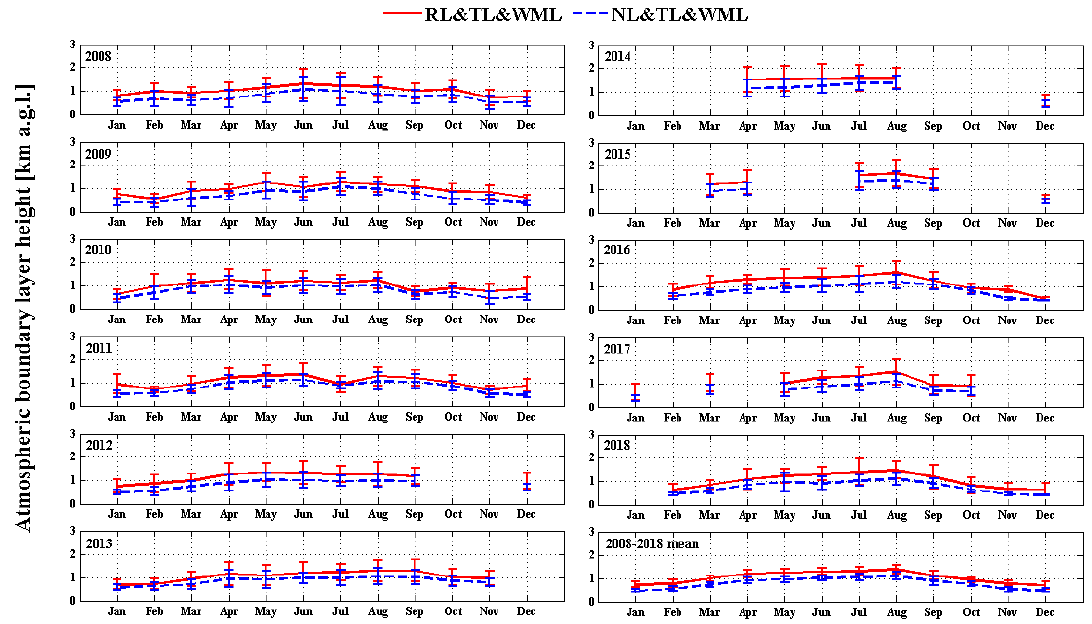
Figure 9. The monthly mean variability of the ABLHs obtained by using the wavelet covariance transform (WCT) method for the PollyXT lidar and the CHM15k ceilometer observations in cloudy and clear-sky conditions over Warsaw, within the period of 2008 to 2018. Merging and homogenization were applied to the lidar data from November 2013 to December 2018.